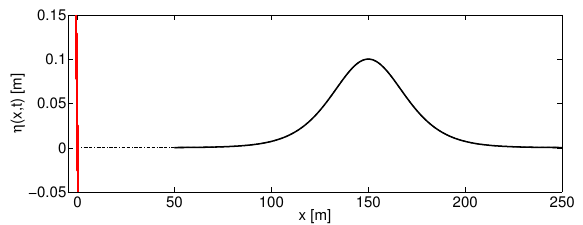
Fig. 5. A solitary wave initial condition for the NSWE (dotted- Figure 5. A solitary wave initial condition for the NSWE (dotted- dashed line) coupled to the linear model (dashed line), and the linear dashed line) coupled to the linear model (dashed line), and the linear model with the EBC implementation (solid line) at x = 50m . The model with the EBC implementation (solid line) at x = 50m. The solid and dashed lines are on top of another. solid and dashed lines are on top of one another.